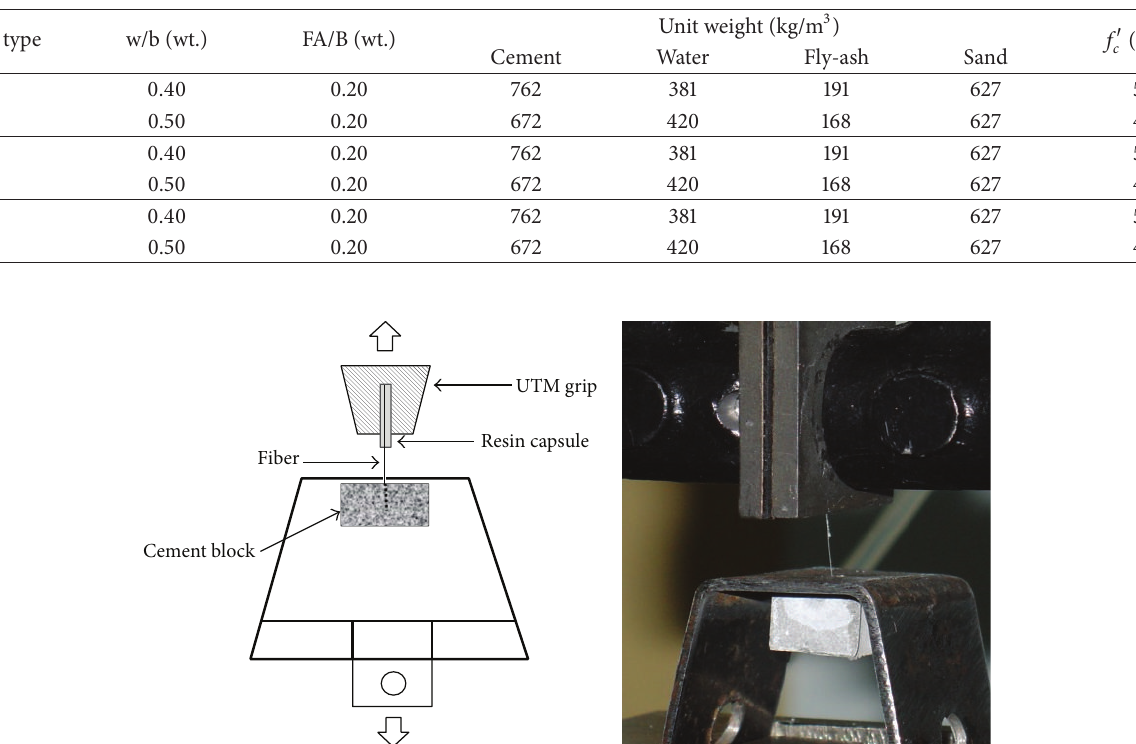
Table 4: Mix proportions for cement composites.